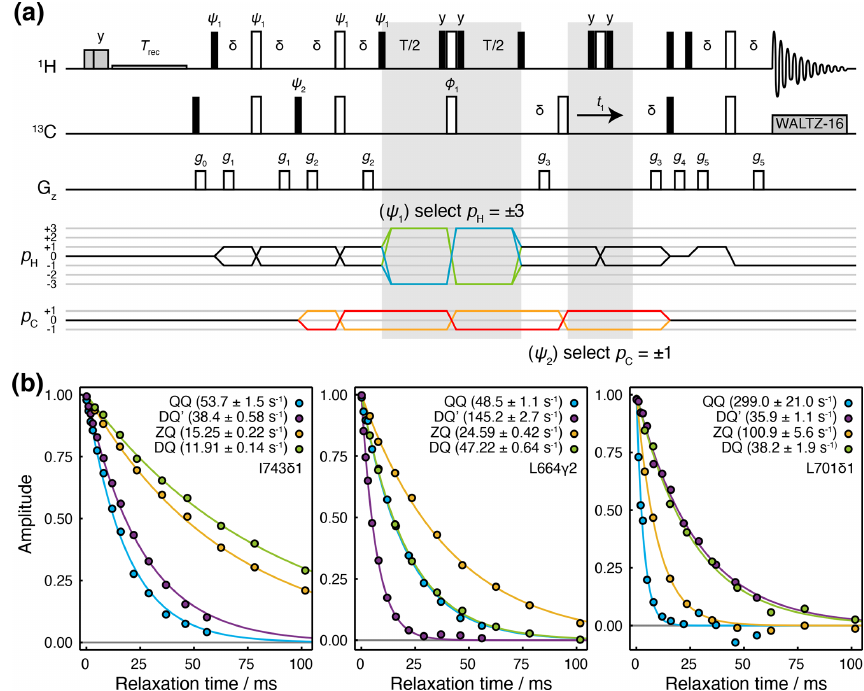
Figure 2. Hahn echo measurement of R 2 relaxation rates for methyl DQ (cid:48) and QQ coherences. (a) Pulse sequence and coherence transfer pathways for the simultaneous measurement of DQ (cid:48) and QQ Hahn echo relaxation rates. Individual steps of the phase cycles ψ 1 = (0 , 51 . 4 , 102 . 9 , 154 . 3 , 205 . 7 , 257 . 1 , 308 . 6) 3 , ψ 2 = 0 ◦ 7 , 120 ◦ 7 , 240 ◦ 7 , are stored and processed post-acquisition to select P- and N- type DQ (cid:48) and QQ coherence transfer pathways. T represents the relaxation time, and the delay δ = 1 / 4 J = 2ms. Shaded grey pulses represent consecutive 5kHz 2ms H x and 3ms H y purge pulses before the recycle delay, T rec (with low-power presaturation applied, if required). φ 1 = x , − x ; receiver phase = x . Trapezoidal gradients were applied with the following powers and lengths: g 0 11Gcm − 1 , 1ms; g 1 14Gcm − 1 , 400µs; g 2 11Gcm − 1 , 200µs; g 4 − 14Gcm − 1 , 300µs; g 4 − 27Gcm − 1 , 500µs; g 5 − 44Gcm − 1 , 700µs. (b) HE relaxation measurements of four-spin DQ (cid:48) and QQ coherences for methyl groups in ILV-labelled FLN5 (800MHz, 283K). Measurements of ZQ and DQ HE relaxation rates are also shown and were acquired using established methods (Gill and Palmer, 2011). Values of fitted relaxation rates are shown in the legends, with uncertainties indicating the standard error derived from